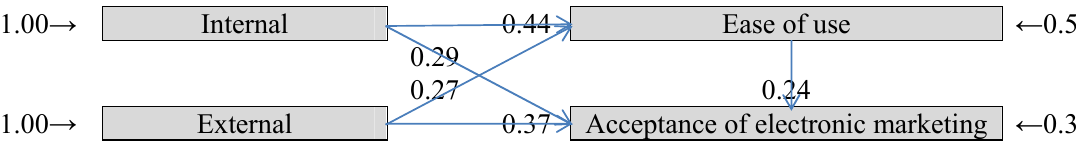
Fig. 2. The summary of the results of SEM among different components (Standard